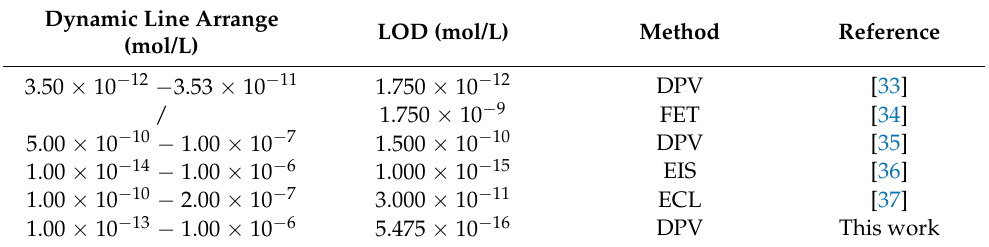
Table 2. Comparison between the proposed DPV sensor and other sensors for HPV-16 assay.